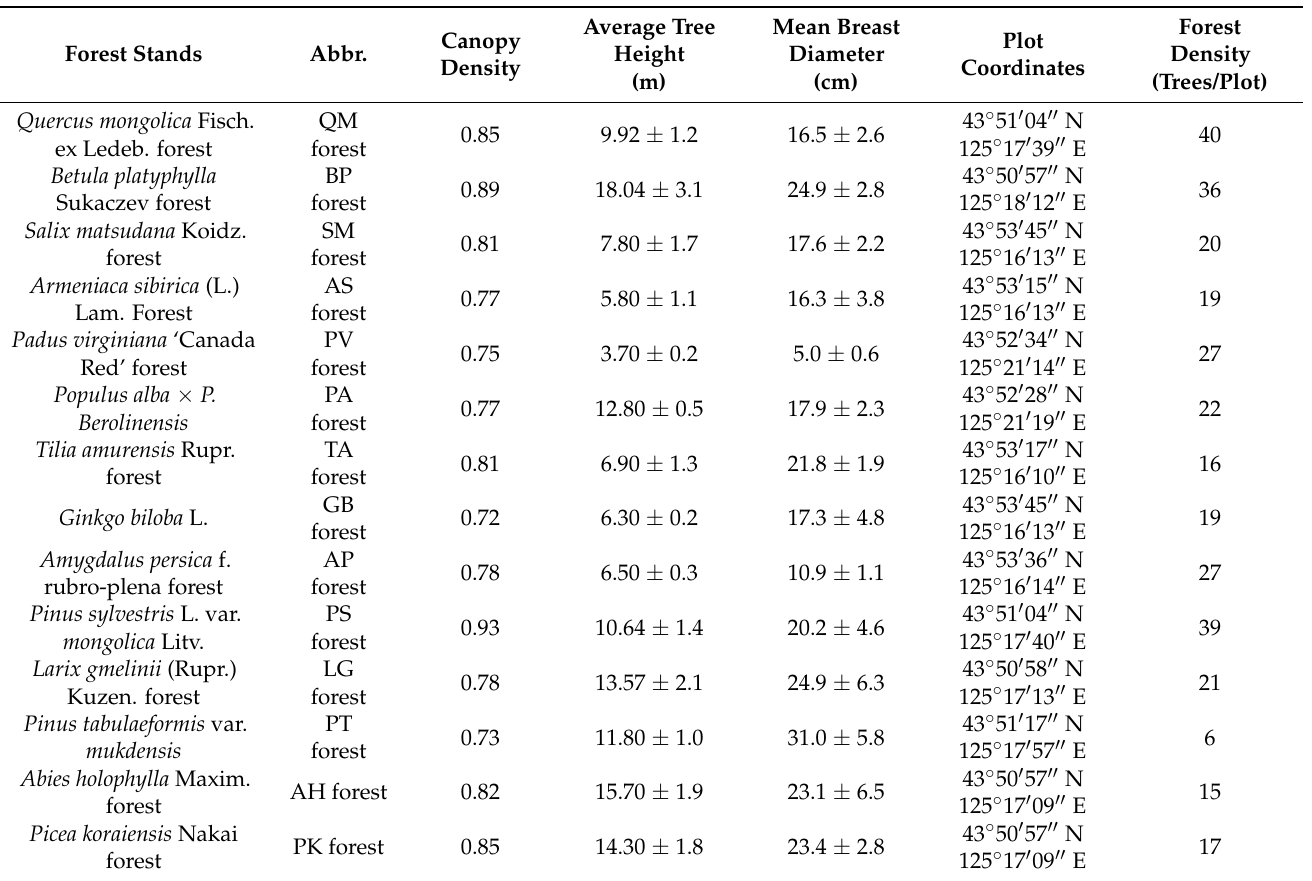
Table 1. Basic condition of 14 forest stand types. Note: Tree height and breast diameter are shown as mean ±